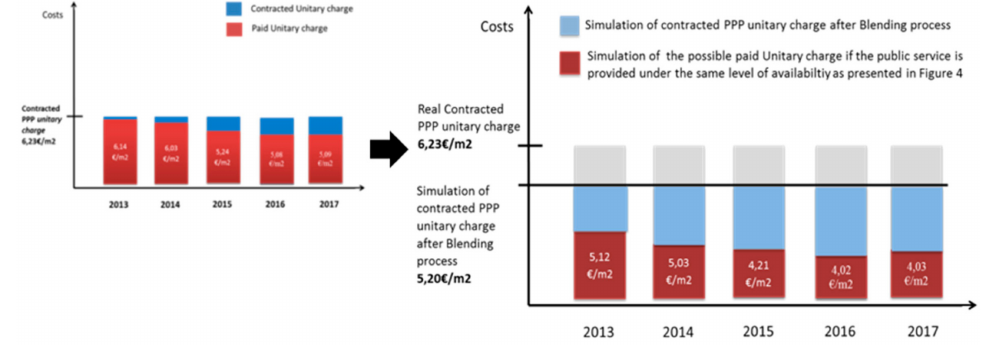
Figure 8. Simulation of paid unitary charge with the e ff ect of blending (based on data from Figure 4). Source: Authors’